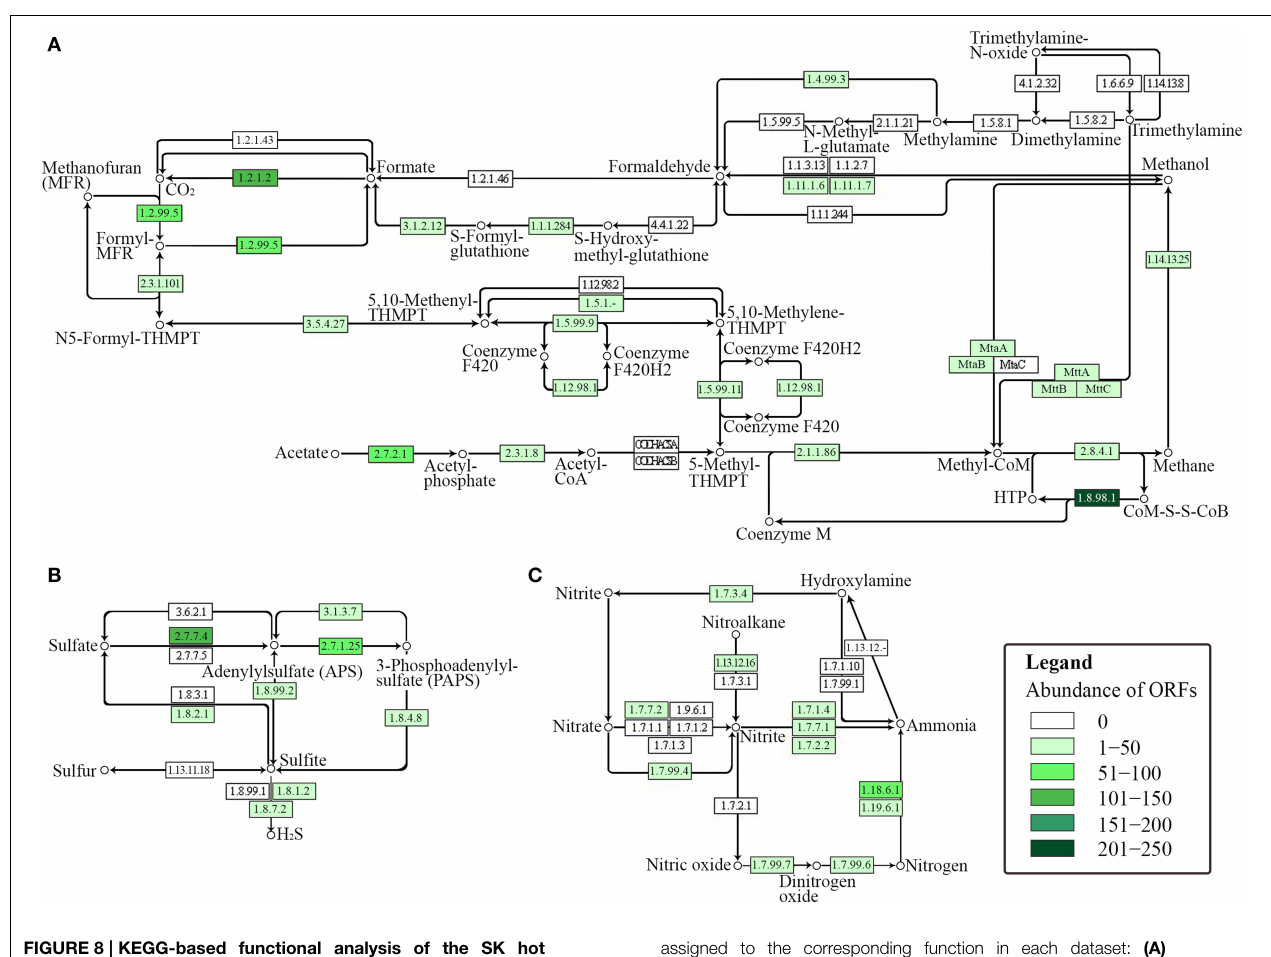
FIGURE 8 | KEGG-based functional analysis of the SK hot spring community. Each numbered rectangle represents participating enzymes. The boxes are shaded according to the number of ORFs